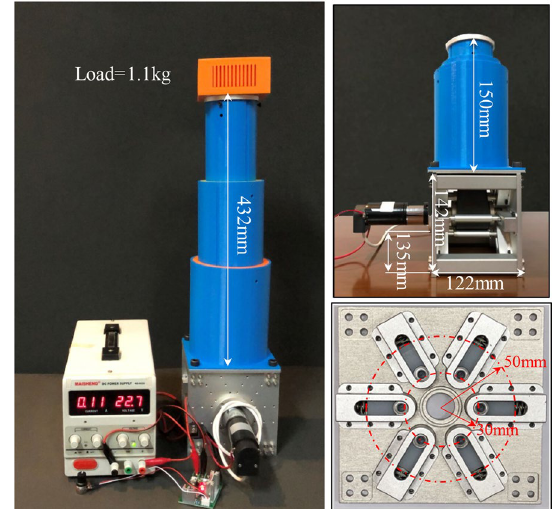
Figure 16 Pareto optimal solution of objective function